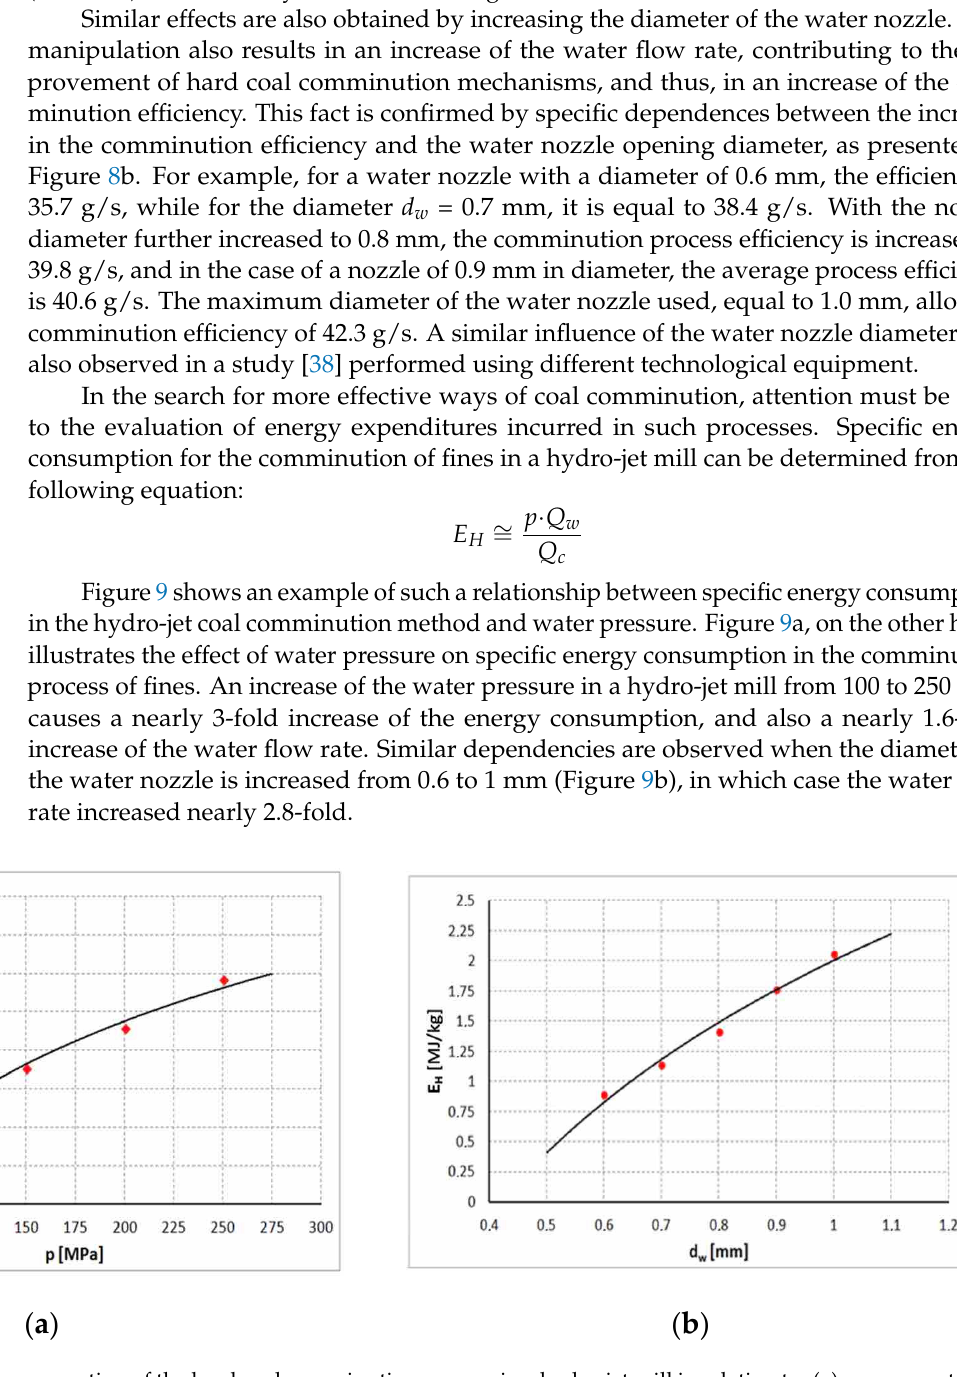
Figure 9. Specific energy consumption of the hard coal comminution process in a hydro-jet mill in relation to: ( a ) pressure, at water nozzle diameter d w = 0.7 mm, and ( b ) water nozzle diameter, at p = 200 MPa. Common test conditions: d c 1 = 2.4 mm, l = 190 mm, s = 10 mm.